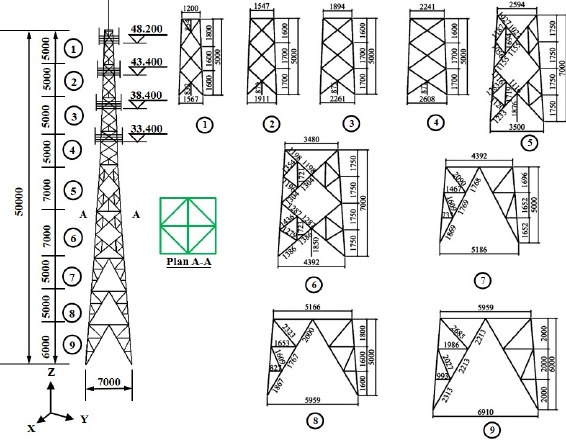
Fig. 1. Sketch of the prototype structure (unit: mm) determined from the standard drawings of communica- tion tower of China iron tower Co., Ltd.. The elevation of tower and each section are shown in Fig. 1. The compo- nent dimensions and additional mass of each section are listed in Table 1. Q235B angle steel was used for the profile steel, inclined material, and plate of the tower. Q345B angle steel was employed for the vertical support member. The mechanical properties of materials are specified in Table